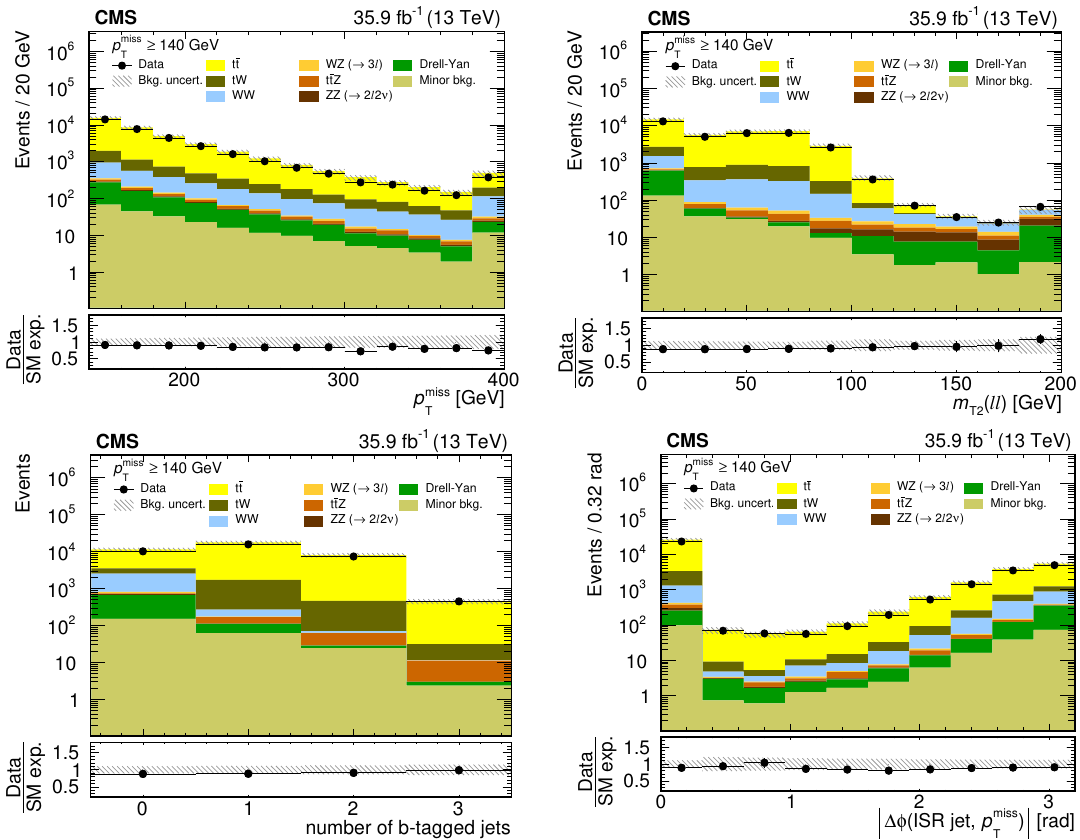
Figure 3 . Observed and SM expected distributions of some observables used to de(cid:12)ne the SRs for (cid:21) 140 GeV. Clockwise from top left: p miss events with two OC isolated leptons and p miss , m T2 ( ‘‘ ), T T (cid:1) (cid:30) between the ~p miss and the leading jet (required not to be b-tagged and with p T > 150 GeV, T events missing this requirements are shown in the (cid:12)rst bin), and multiplicity of b-tagged jets in the event. The last bin includes the over(cid:13)ow entries. The contributions of minor backgrounds such as ttW, H ! WW, and triboson production are grouped together. In the bottom panel, the ratio of observed and expected yields is shown. The hatched band represents the total uncertainty in the background expectation, as described in section